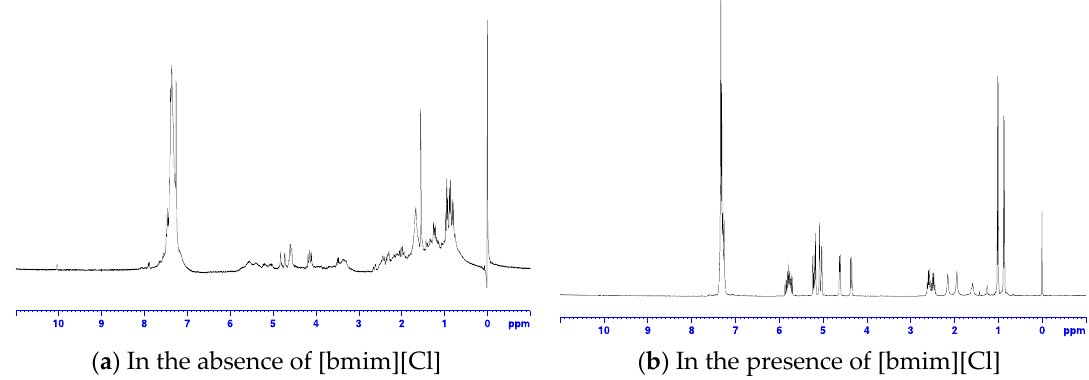
Figure 1. Crotylation of benzaldehyde in [bmim][BF 4 ] in the absence ( a ) or presence ( b ) of [bmim][Cl].